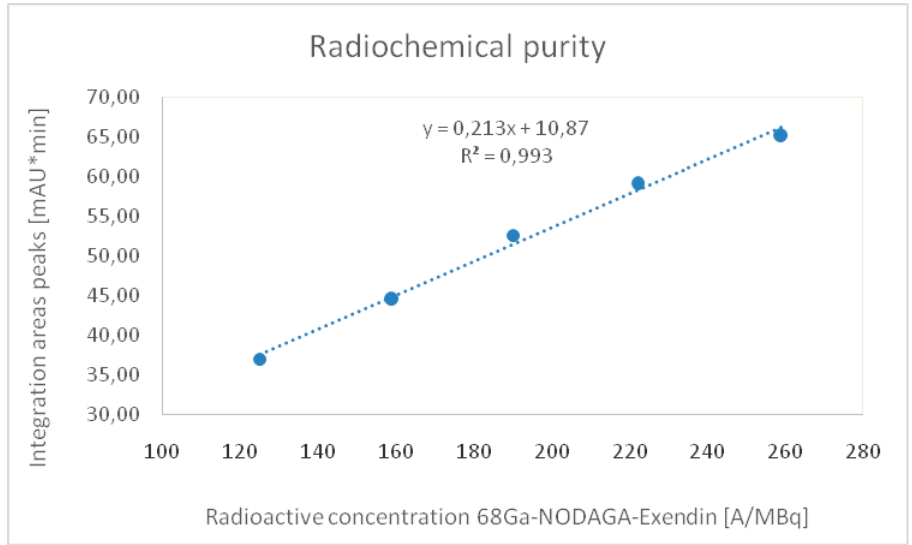
Figure 4. Calibration curve obtained with the average values of peak areas of [ 68 Ga]Ga-NODAGA-exendin-4. Table 2. Tests and acceptance criteria in determining radiochemical purity using UV-Radio-HPLC. Test